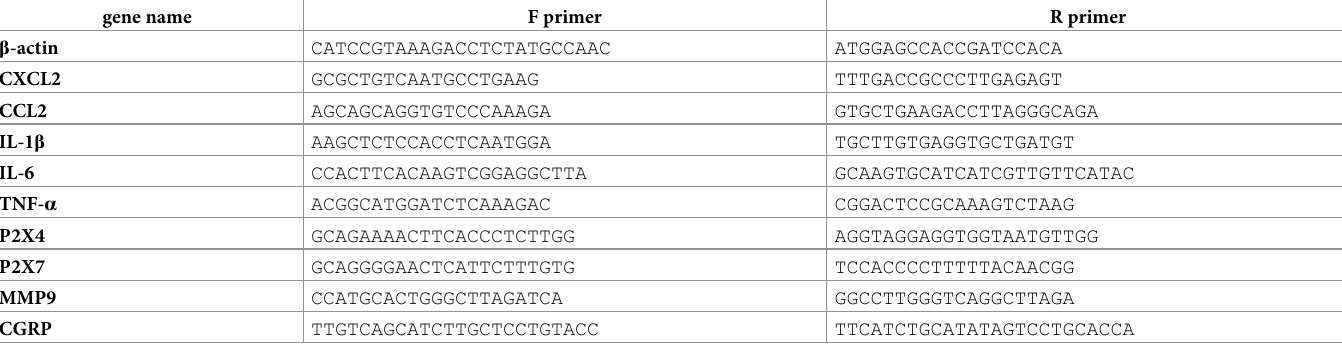
Table 1. Sequences of primers used for